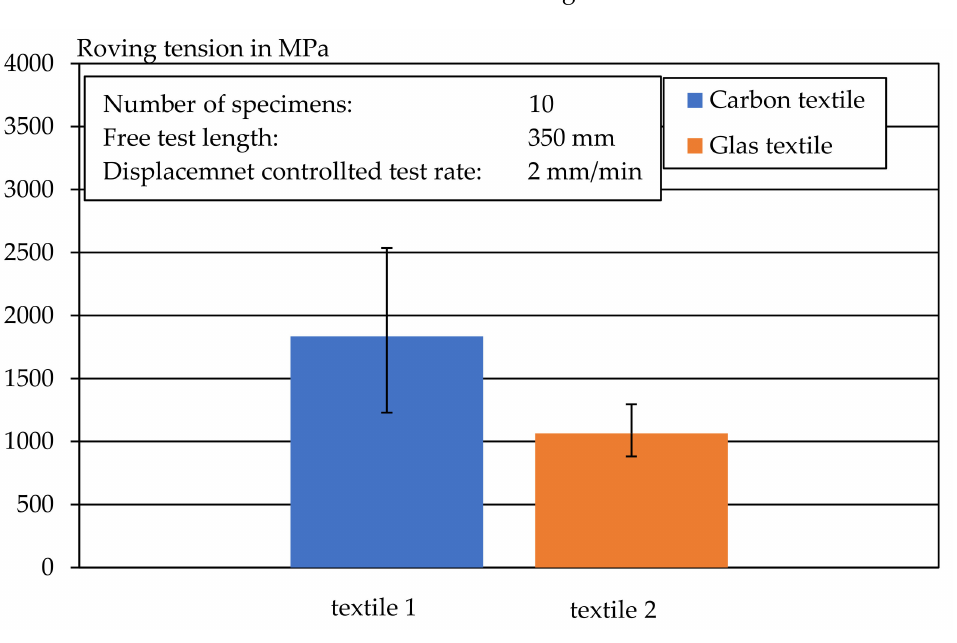
Figure 9. Tensile strength of longitudinal glass and carbon textile rovings.